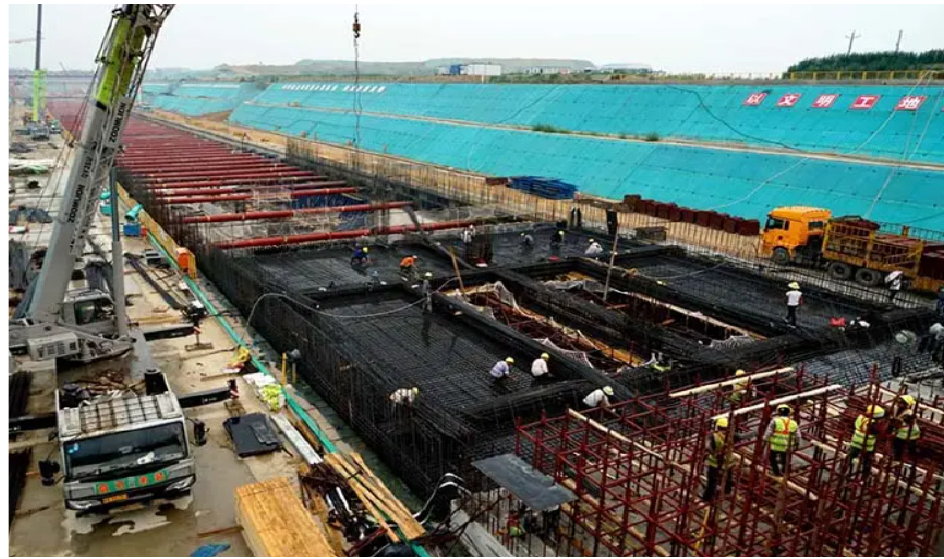
Figure 7. Job site